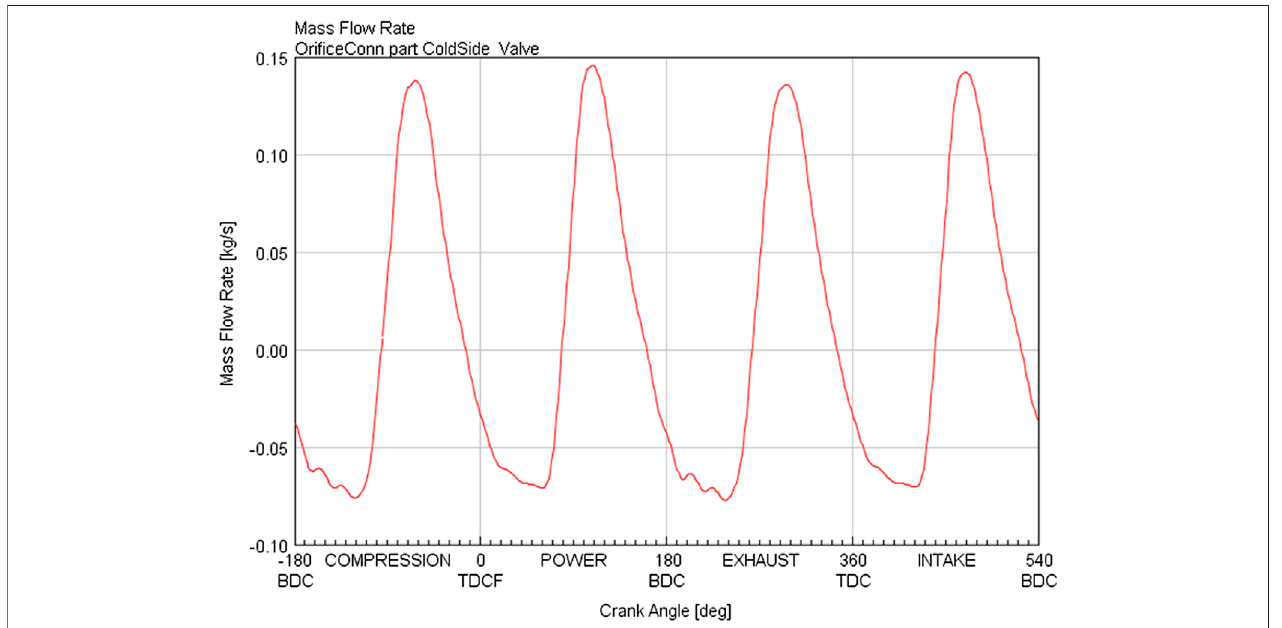
FIGURE 8 | HP-EGR mass fl ow rate indicating back fl